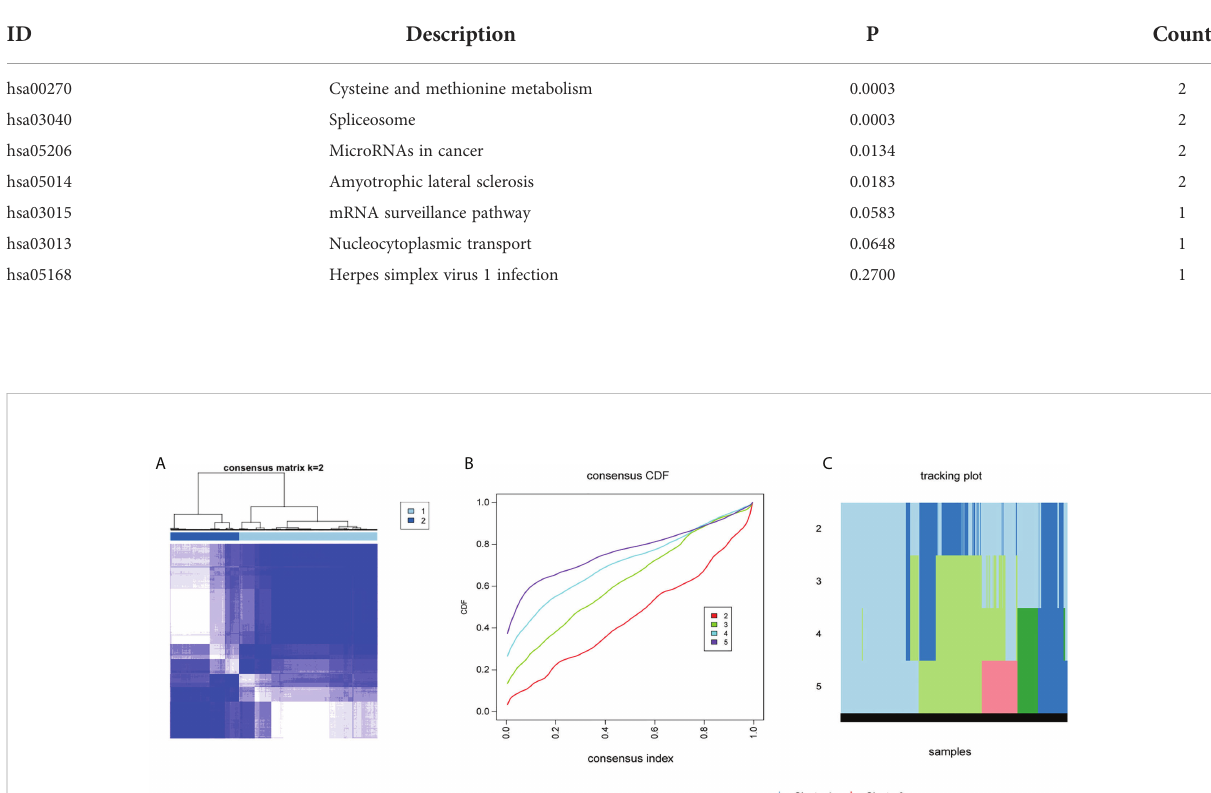
TABLE 3 KEGG enrichment analysis of differentially expressed m 6 A/m 5 C/m 1 A-related genes.